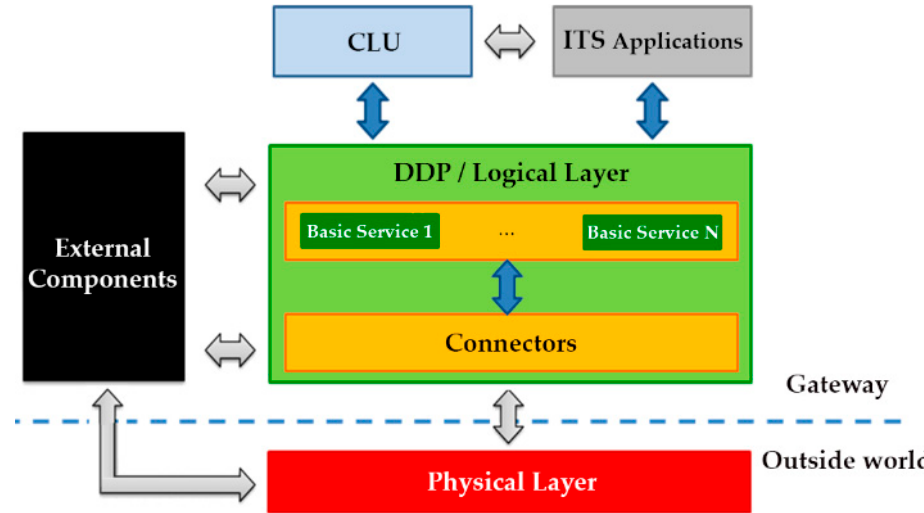
Figure 2. Software Architecture of platform on GWs.